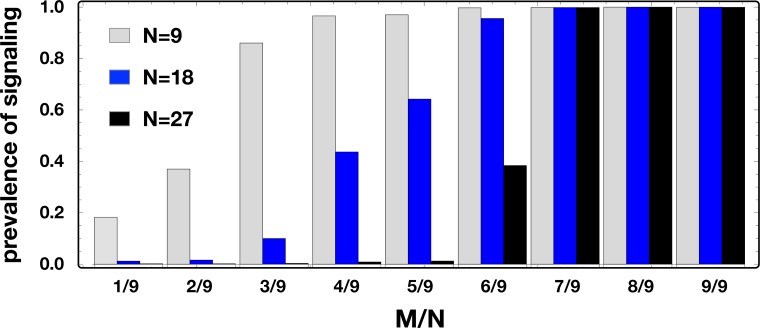
Prevalence of signaling strategies (10|01) and (01|10).We consider three different group sizes, N = 9 (gray bars), N = 18 (blue bars) and N = 27 (black bars), and different values of the coordination threshold M. Signaling strategies prevail in those situations in which coordination is harder to achieve (large M). Furthermore, larger groups must be subjected to stronger requirements such that signaling emerges and the public good is achieved. Other parameters: Z = 100, c = 0.5, c
s = 0.2, γ = 2, F = 10, λ = 0.5.